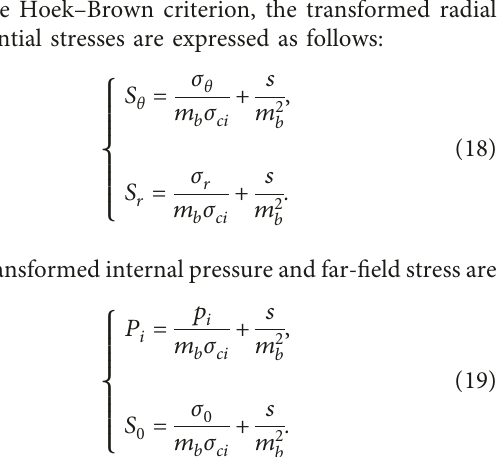
R / R p and i i 1 1 ( ) (cid:31) ( ) − −